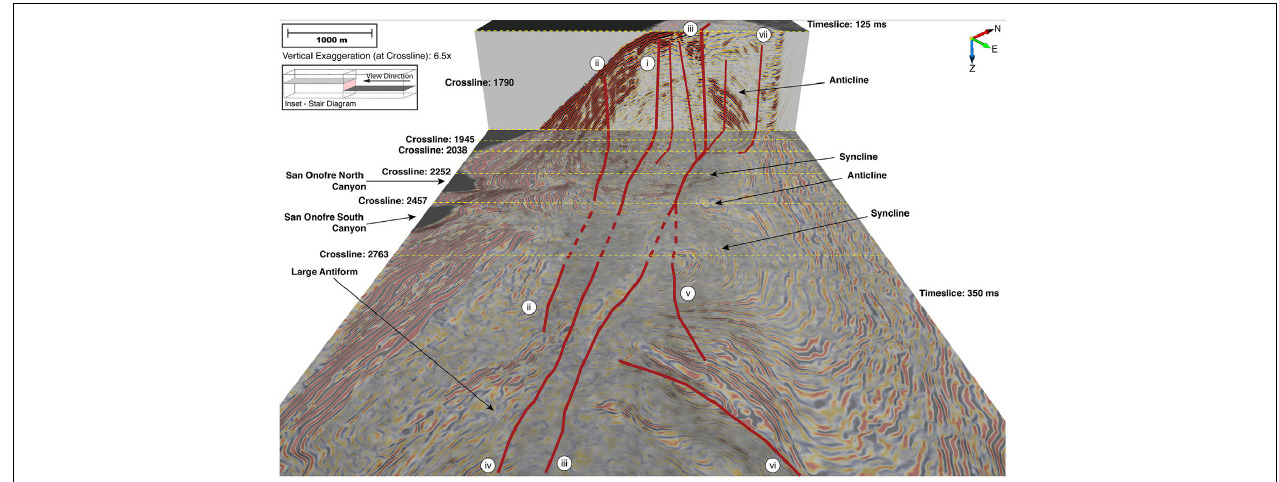
FIGURE 3 | Vertical profile of crossline 1790 amplitudes showing fault interpretations in solid red Location of the crossline, relative to the survey area, is shown in Figure 1C . All crosslines shown in stair diagrams are bounded by time-slices at 125 and 350 ms. Both time-slices for all stair diagrams in Figures 3–9 , 12 are rendered using a combination of similarity data and amplitude data at 60% transparency. View direction is toward the northwest. Thick lines denote major fault segments i, ii, and iii. Thin lines denote secondary fault systems no; faults are dashed in the lower (350 ms) time-slice, where there is more uncertainty. Alternating anticline/syncline sequence can be observed in the lower time-slice. The outline of a large structural dome, labeled as a large antiform, is observed toward the bottom of the figure in the lower time-slice. Yellow dashed lines show locations of crosslines shown in other figures. Black areas in the southwest part of the lower time-slice represent shelf incisions from channelization. (Inset) Schematic view of data volume depicting view angle of stair diagrams used in this paper.